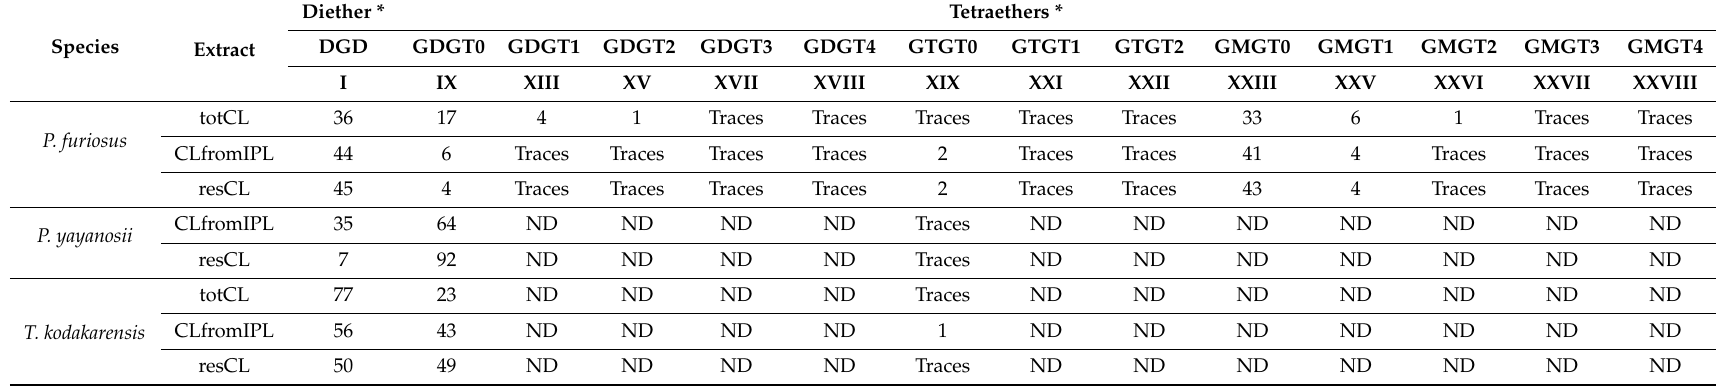
* Relative proportions account for protonated, ammoniated and sodiated adducts in positive mode and for deprotonated adducts in negative mode, and were calculated assuming a response factor of 1 for all IPL (see methods). Traces, < 1%. ND: not detected. Table 2. Core lipid composition (relative %) of the total cell pellet (totCL), the total lipid extract (CLfromIPL) and the pre-extracted pellet (resCL) of Pyrococcus furiosus , P. yayanosii and Thermococcus kodakarensis